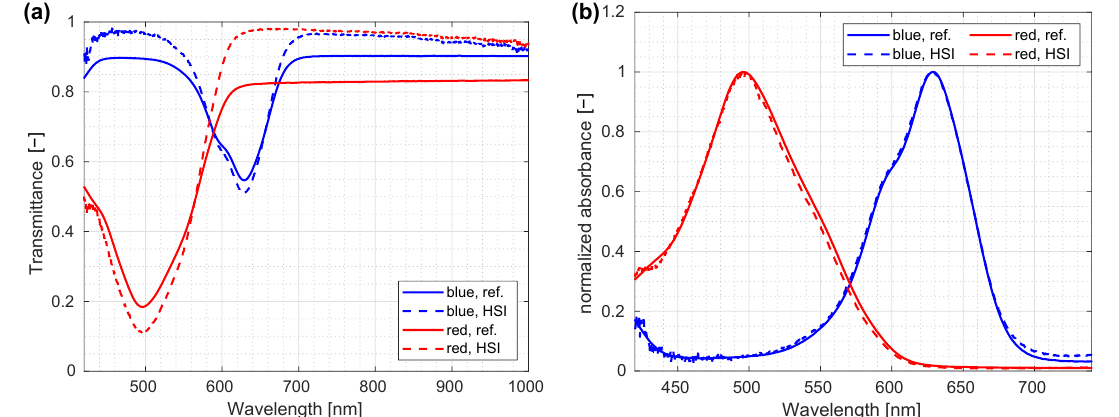
Figure 11. Comparison between the transmission spectrum of a custom-made laboratory hyperspec- tral imaging (HSI) system and reference spectrum: ( a ) direct comparison of spectra; ( b ) comparison of normalized